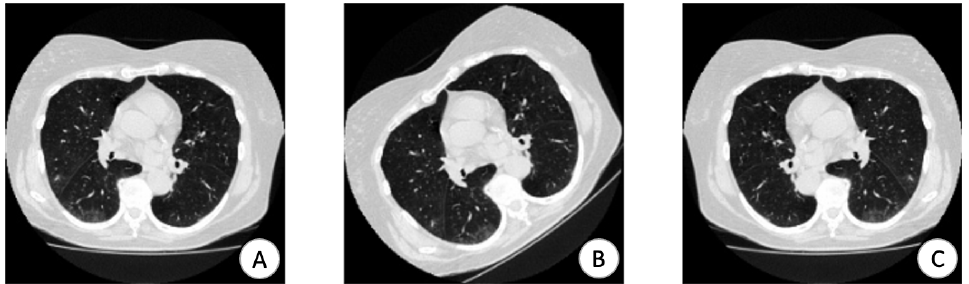
Figure 1. Data augmentation: ( A ) original, ( B ) rotation, and ( C ) flipping.